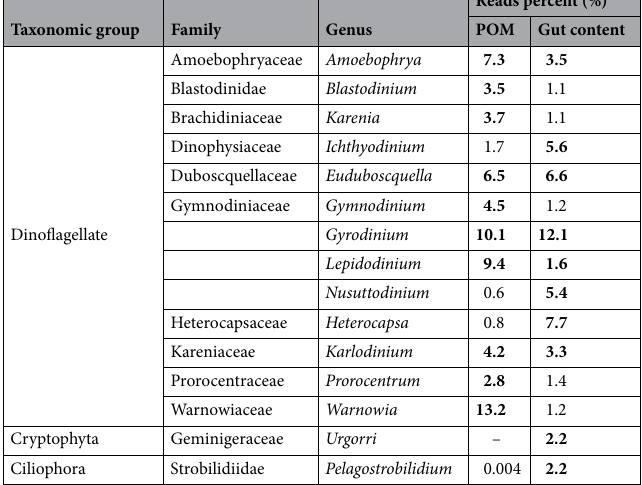
Table 2. Top 10 most abundant genera in NGS reads in gut contents and POM. Bold number indicates high abundance in POM or gut contents. “–” indicates no detection.